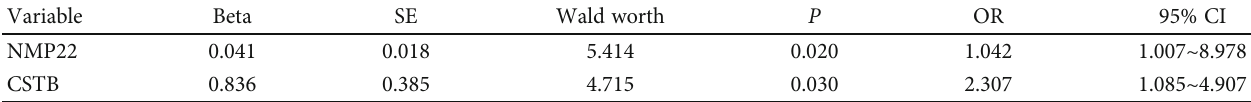
Table 3: Multiple logistic regression analysis of postoperative recurrence of bladder carcinoma.